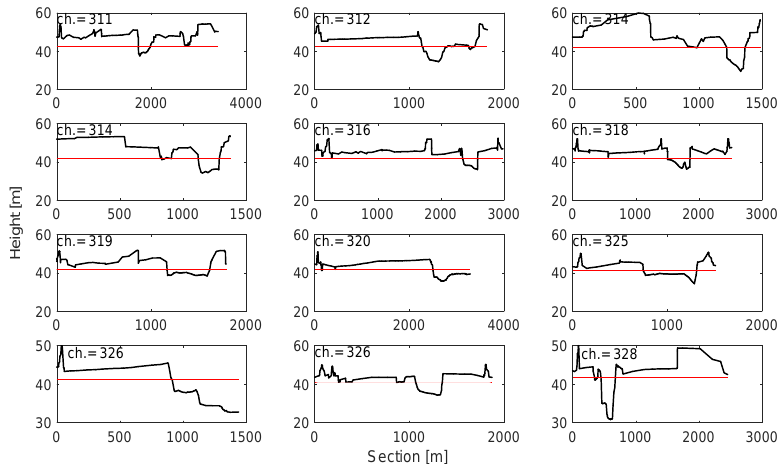
Figure A3. Sections along Reach 4. The red straight line represents the average water level obtained from